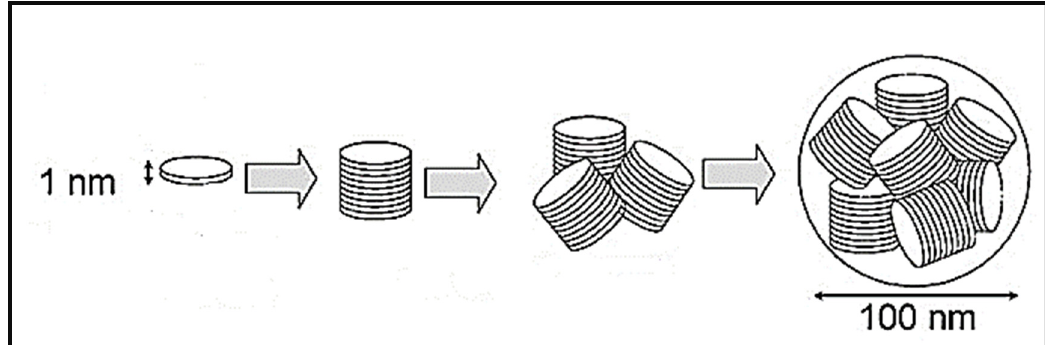
Figure 1. Schematic representation of an elementary disc crystal, stacked discs, and an aggregate and a cluster of stacked discs of Laponite ® [9].